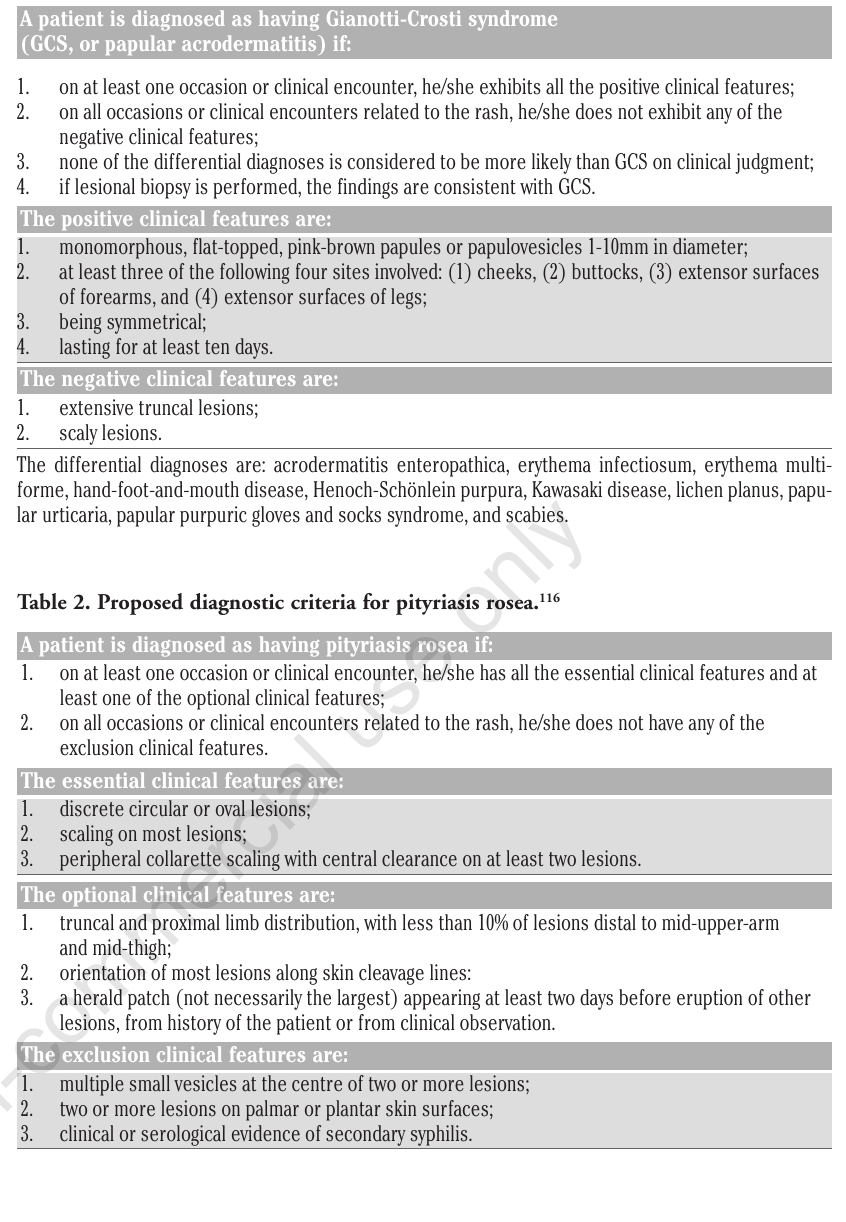
Table 1. Proposed diagnostic criteria for Gianotti-Crosti syndrome .